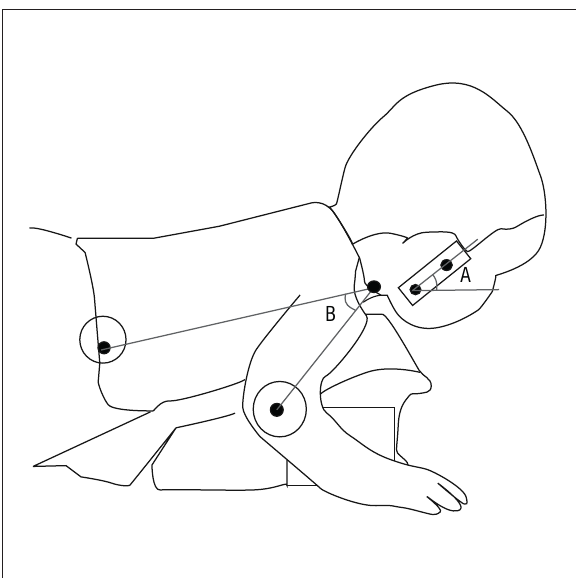
Figure 1 - Angles measured in the sagittal plane: A) align- ment of the head; B) alignment of the upper limb